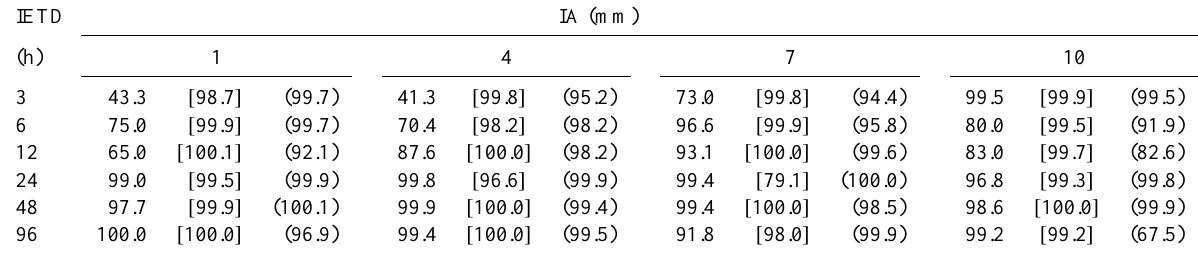
Table 7. p -values (%) obtained when testing the trivariate copula for the rainfall series of Brescia, Parma [.], and Naples (.).